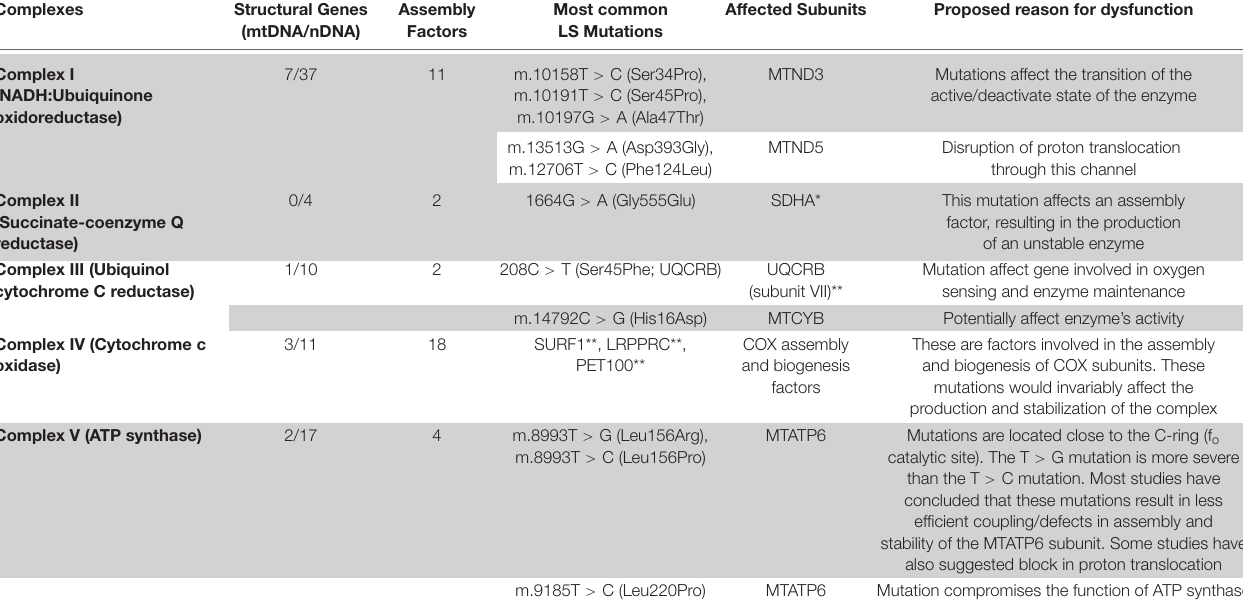
TABLE 1 | The electron transport chain complexes (ETC) with subunits encoded by mitochondrial (mtDNA) and nuclear DNA (nDNA). Complexes Structural Genes Assembly (mtDNA/nDNA)